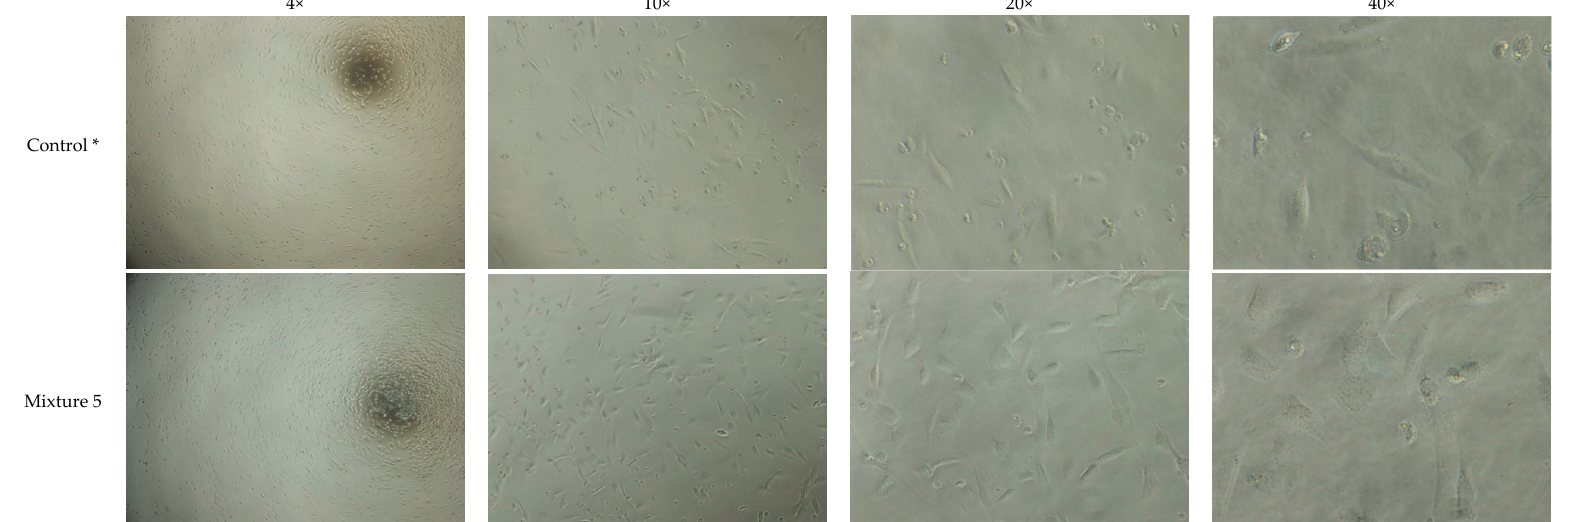
Figure 3. Light microscope images (4×, 10×, 20× and 40× magnification) of human OMECs after 3 days of culture on HA hydrogel scaffold mixture 5 dried for 3 days and coated with 1 mg/mL collagen IV. It was the best attachment and cell density compared to other tested gelation/drying times of mixture 5 (i.e., 3, 7, 10 and 14 drying days). * Cultured human OMECs on coated plastic 24-well-plate with 1 mg/mL collagen IV.